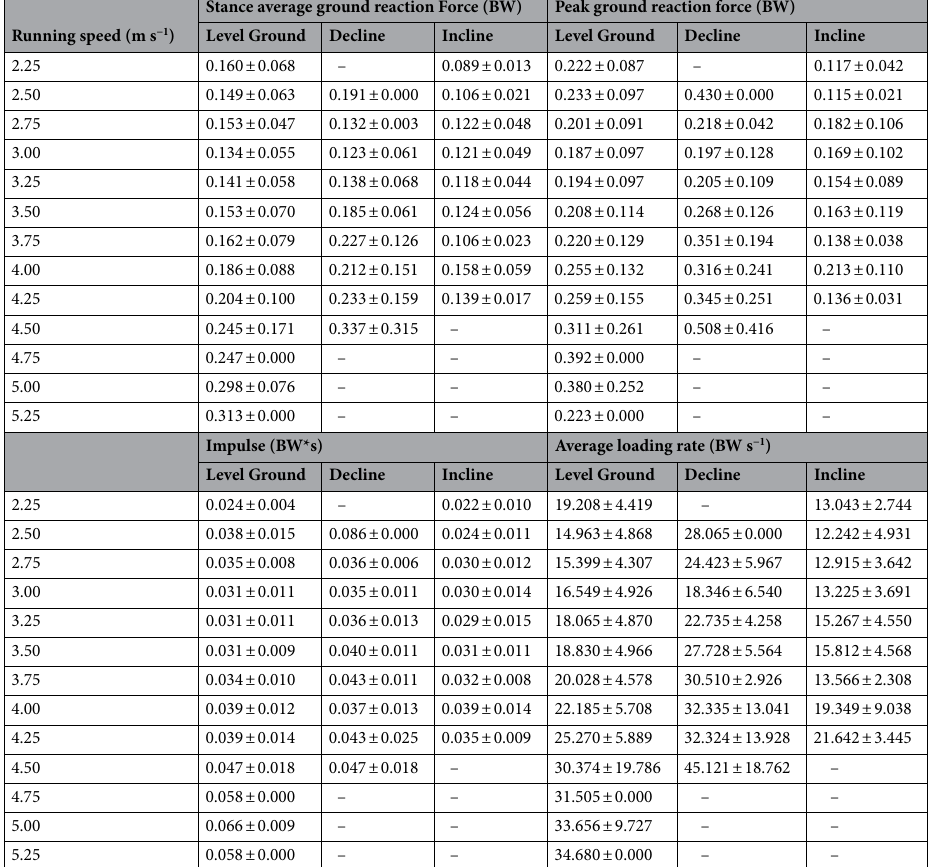
Table 6. Kinetic variable RMSE from BD-LSTM estimated